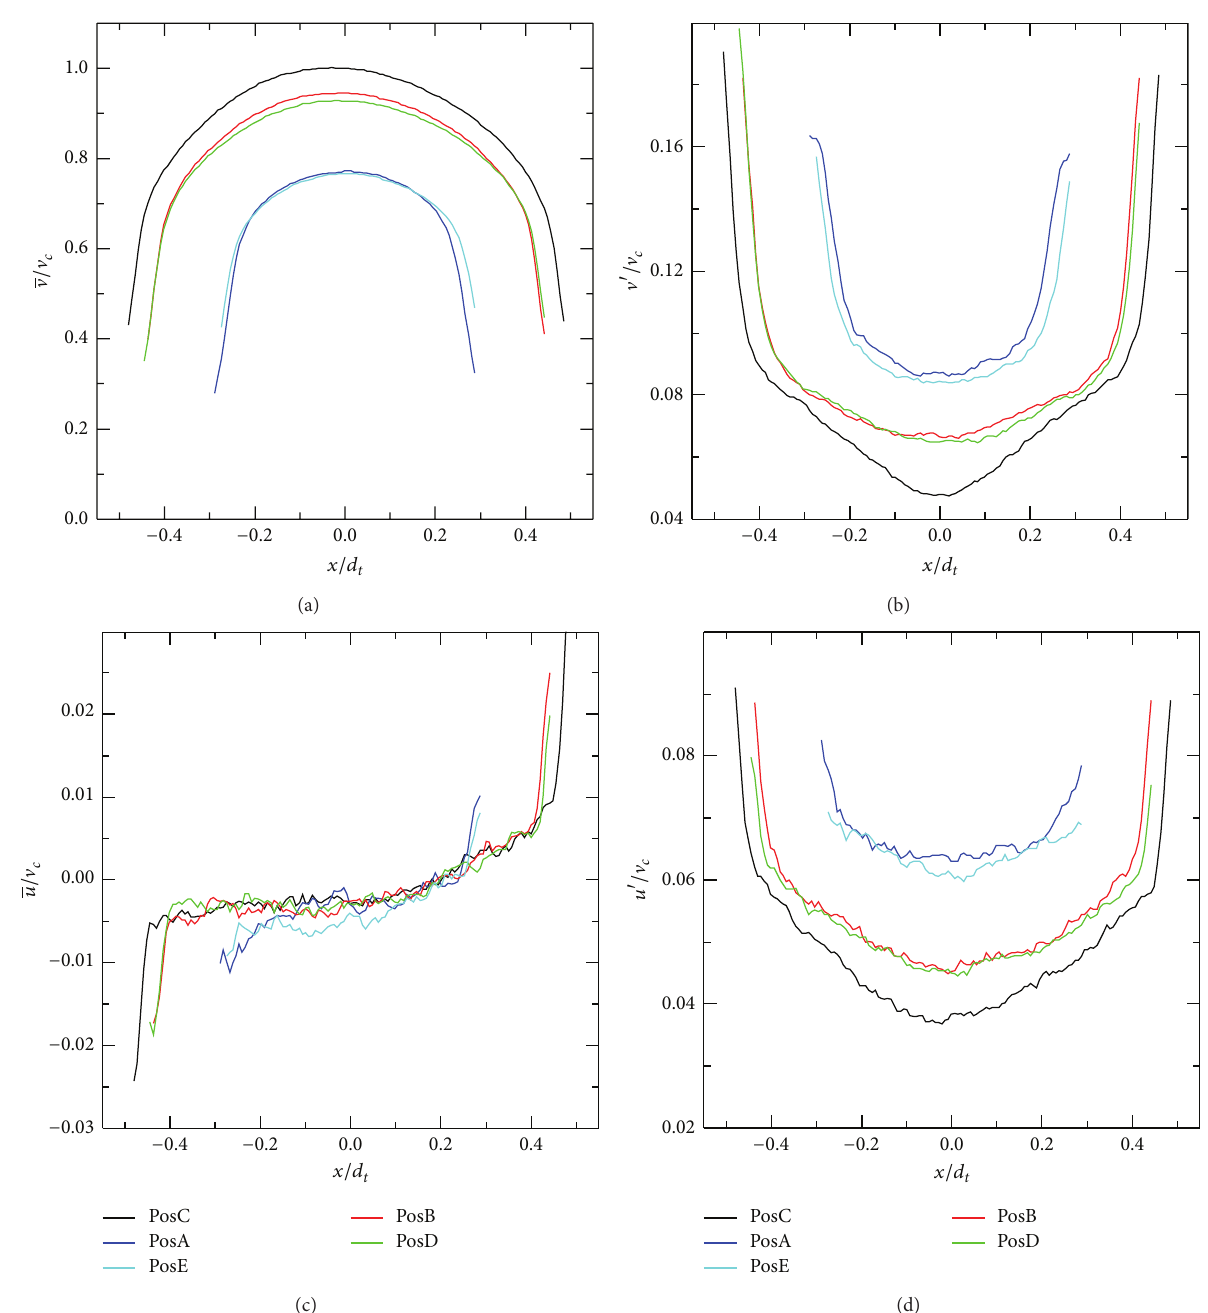
Figure 6: Normalized mean axial V and lateral 𝑢 velocity profiles ((a) and (c)) and the corresponding V 󸀠 and 𝑢 󸀠 ((b) and (d)) for the measurement planes A–E (Figure 4) at 𝑦/𝑑 𝑡 = 0.097 above the injection pipe exit.